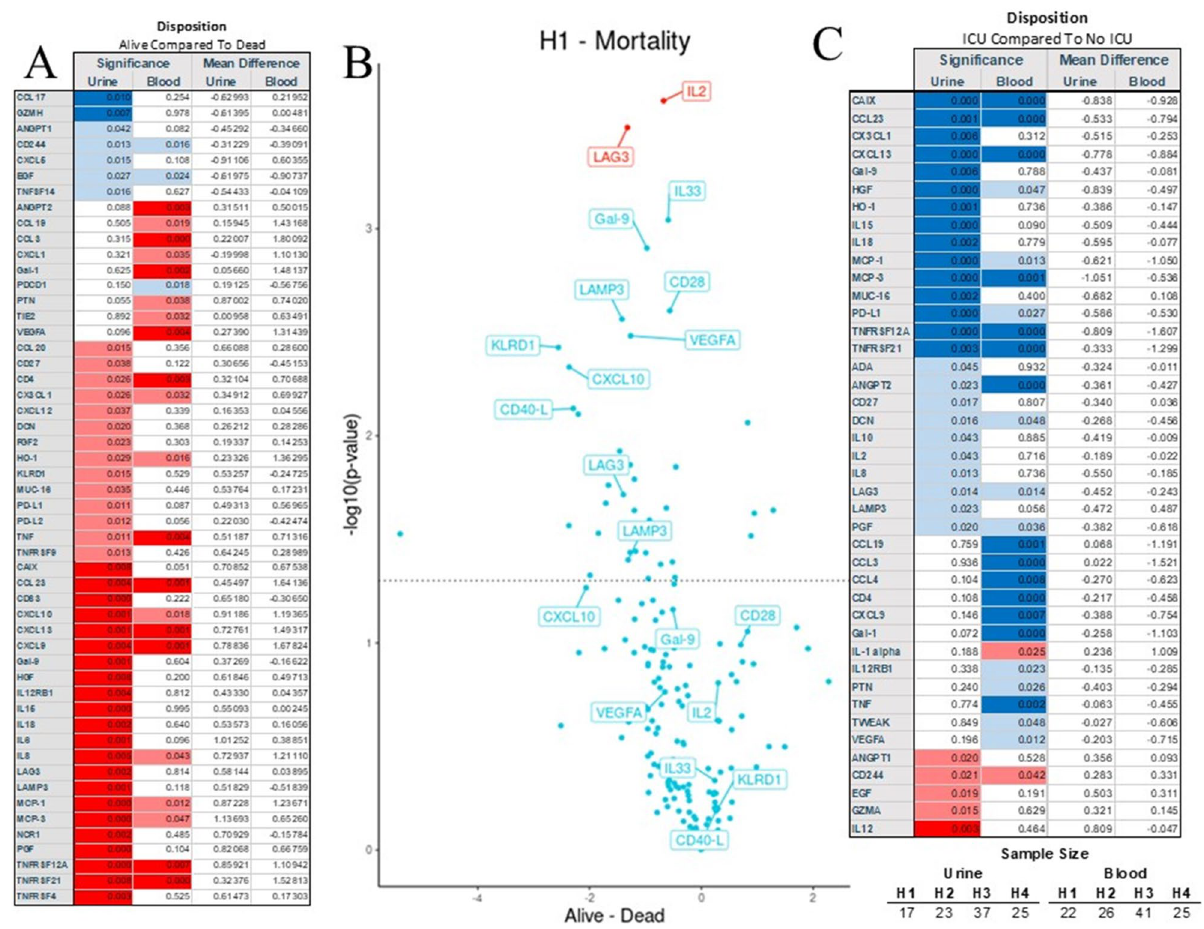
only one significantly elevated ( C